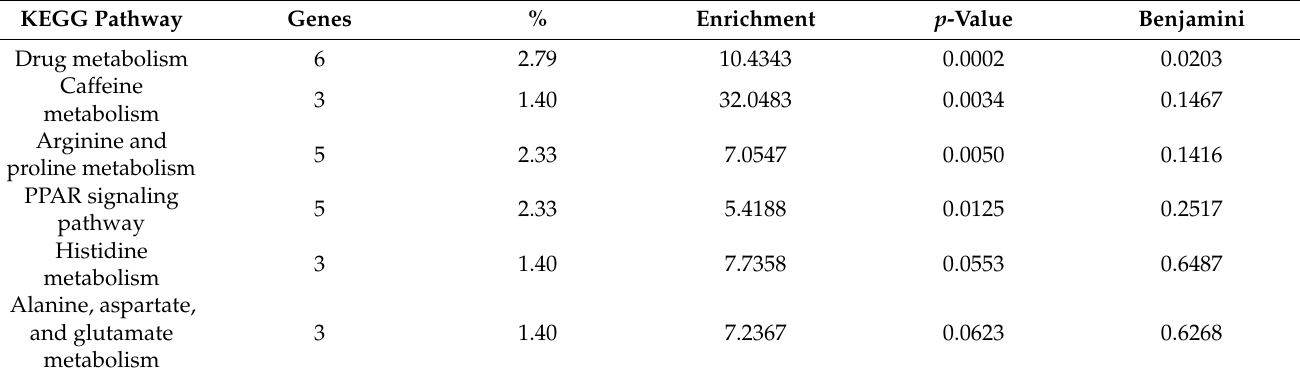
Table 2. Enriched gene ontology terms of the transcripts in chronic atrophic gastritis compared with the control